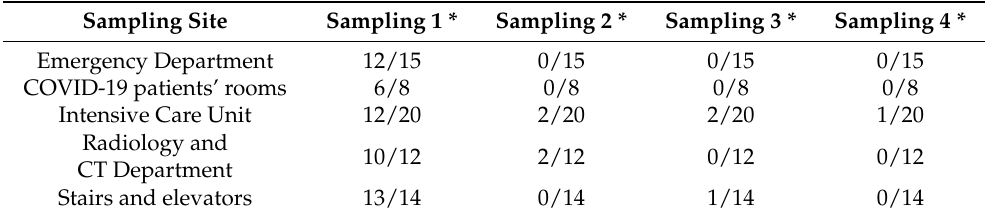
Table 1. Samples tested positive for bacteria in Hospital A by sampling site and sampling phase.